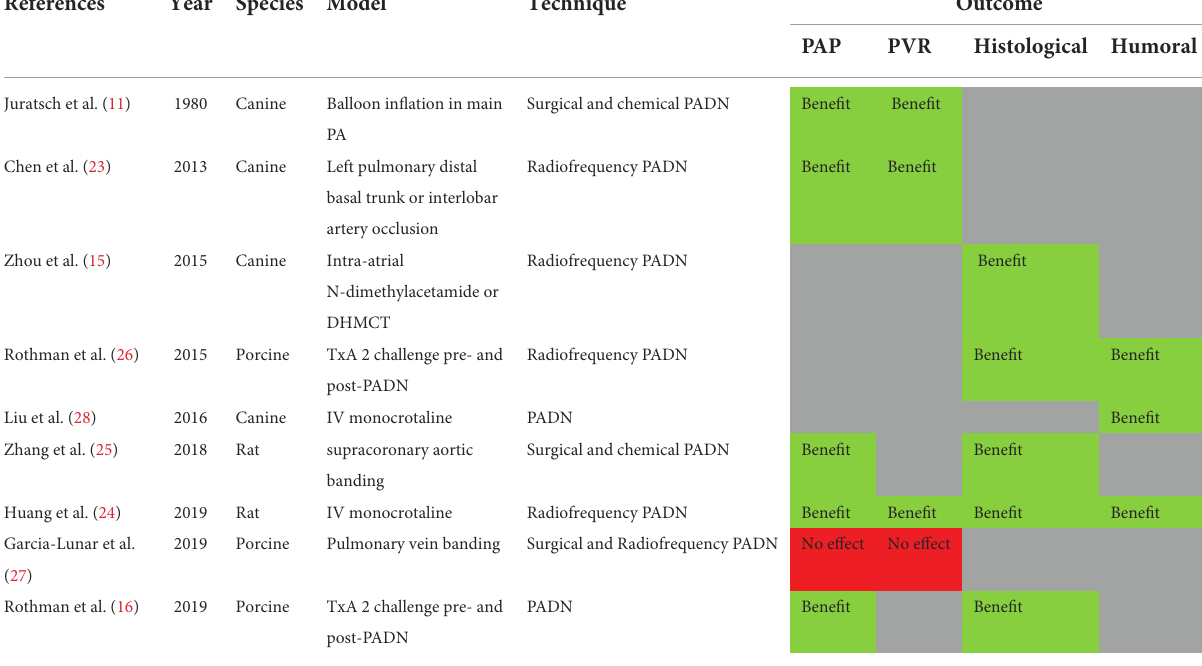
TABLE 2 Experimental studies of